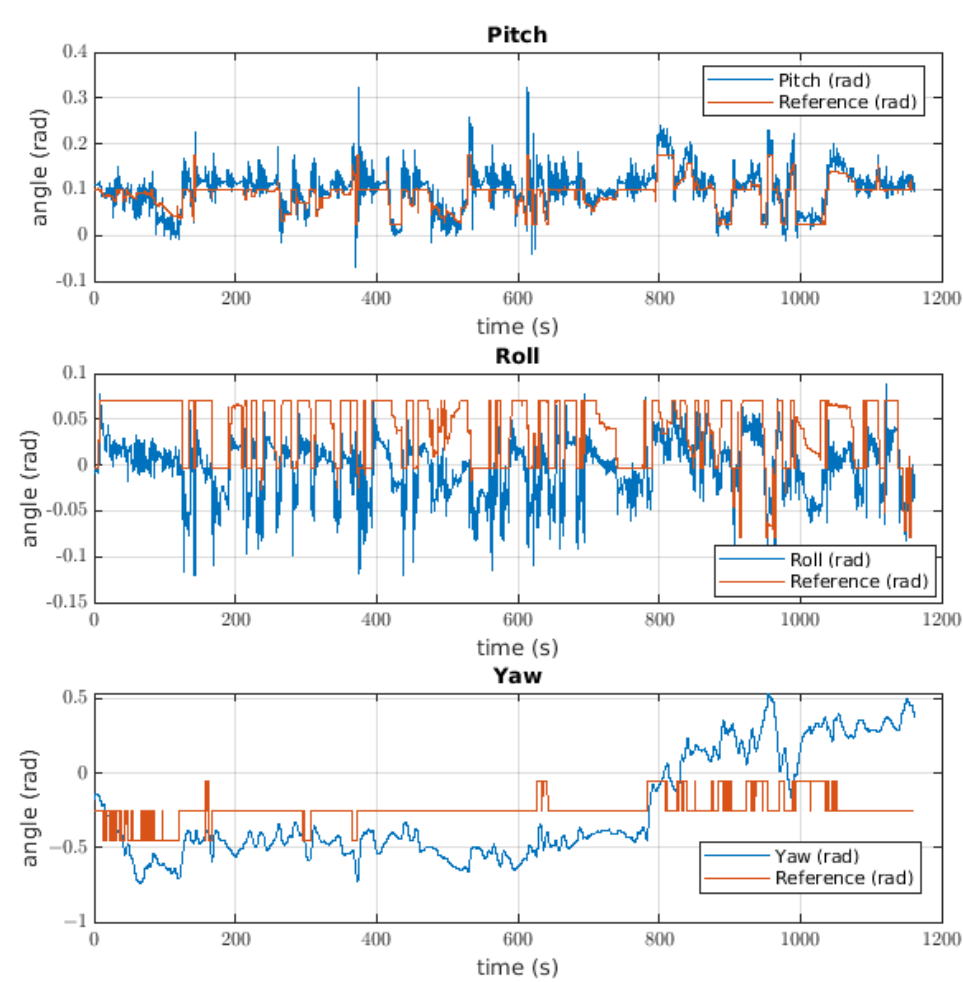
Figure 19. Attitude controller used by the robot to catch a bottle.